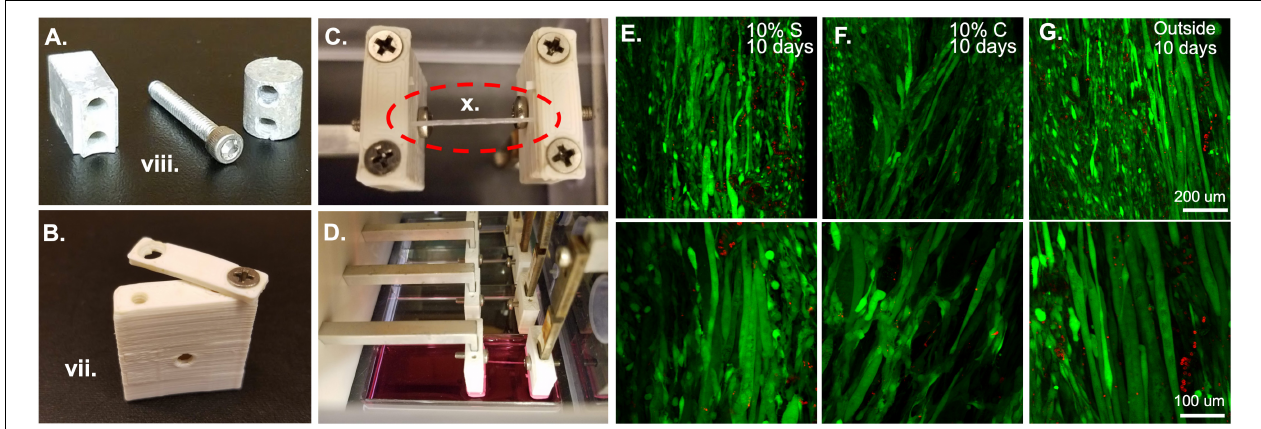
FIGURE 3 | Bioreactor for strain application. (A) Metal components of the bioreactor, such as these force sensor attachment screws and spacers are autoclaved prior to sterile assembly. (B) Plastic ABS pieces such as this sleeve and clamp are soaked overnight in 70% ethanol prior to bioreactor assembly. (C) Following assembly of the system, fibrin microfiber samples are clamped into place in the inverted bioreactor. (D) Once the fibers are clamped, the bioreactor is flipped upright, and the sample is placed in media for culture. (E) Initial tests of 10% static and (F) 10% cyclic strain in the bioreactor demonstrate cell survival through live (green)/dead (red) staining similar to that of (G) cells grown outside the bioreactor. Roman numerals refer to the list of materials at the beginning of Materials and Equipment.